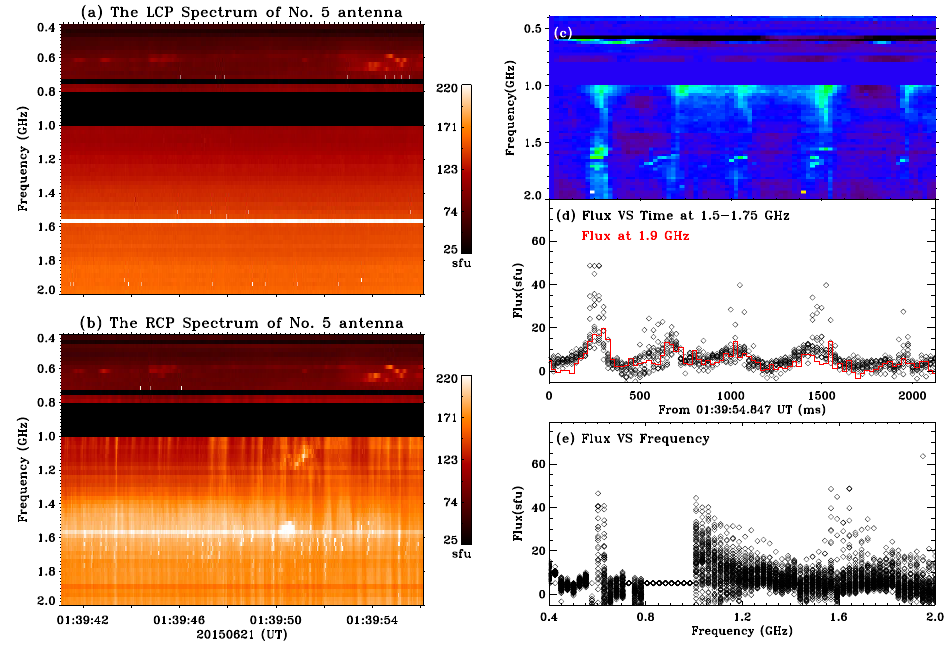
Figure 3. ( a , b ) The spectrum from 01:39:41.97 UT to 01:39:56.97 UT in LCP and RCP observed by the No.5 antenna of MUSER-I. ( c ) The zoomed-in spectral structure of QPSs from 01:39:54.847 UT. ( d ) The temporal evolution of the intensity of spikes by subtracting the continuum emission. ( e ) The frequency distribution of the intensity of spikes by subtracting the continuum